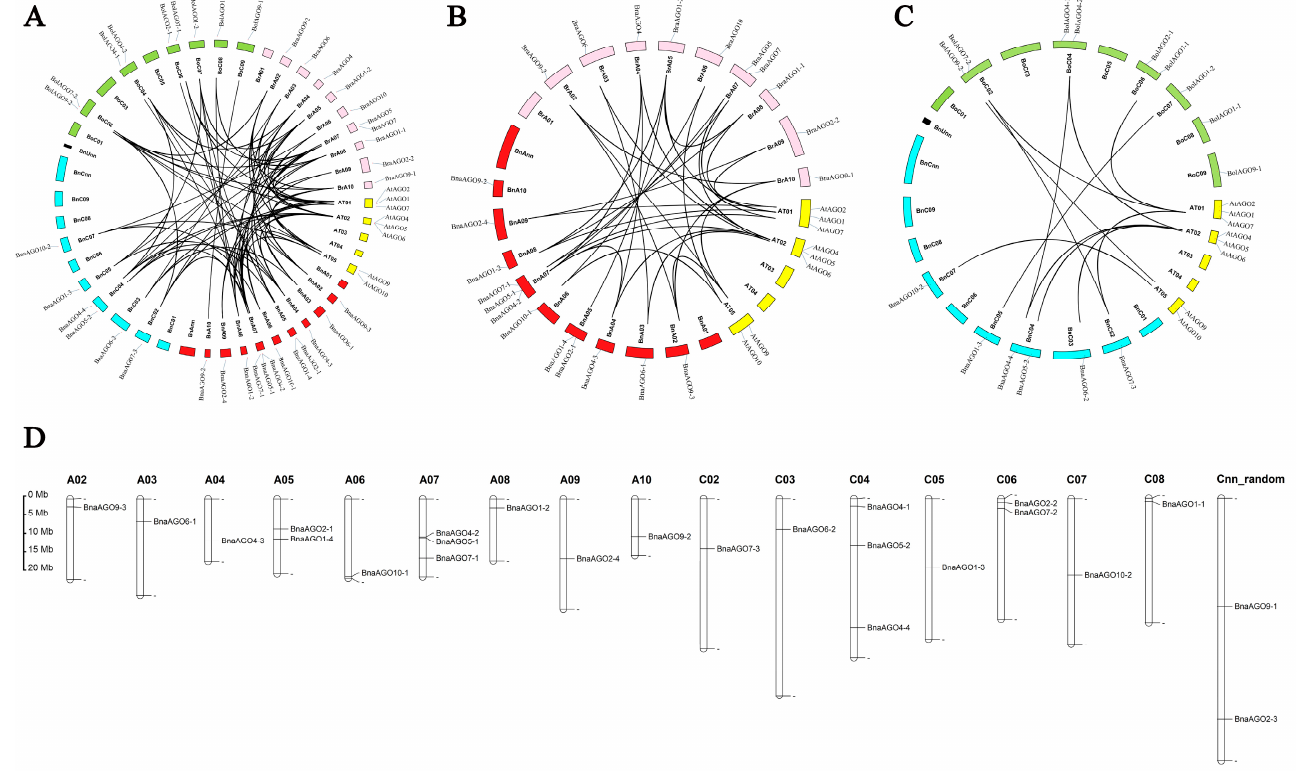
Figure 2. Syntenic relationships of AGO genes ( A – C ) and the chromosome location of the 24 BnaAGOs ( D ). ( A ) Syntenic relationships of the total 58 AGOs among the 4 species. ( B ) Syntenic relationships of AGOs among the A. thaliana , B. rapa and A-subgenomic from B. napus . ( C ) Syntenic relationships of AGOs among the A. thaliana , B. oleracea and C-subgenomic from B. napus . Table 1. The copy number of AGOs among A. thaliana , B. rapa , B. oleracea , B. napus with A and C sub-genomes.